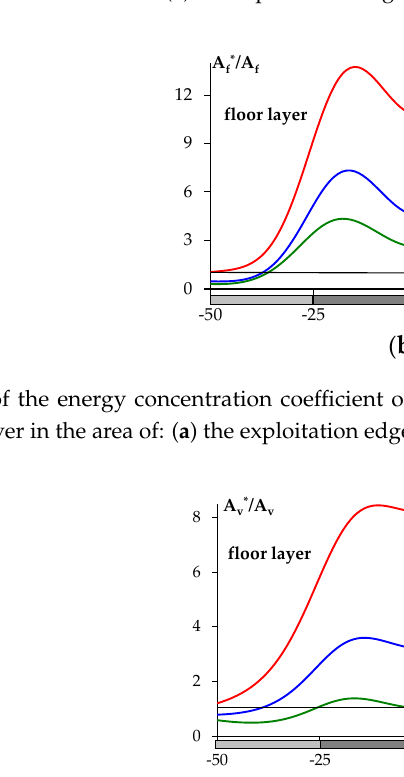
Figure 7. Distribution of the energy concentration coefficient of volumetric strain for different strain properties of the roof layer in the area of: ( a ) the exploitation edge, ( b ) the residual pillar.